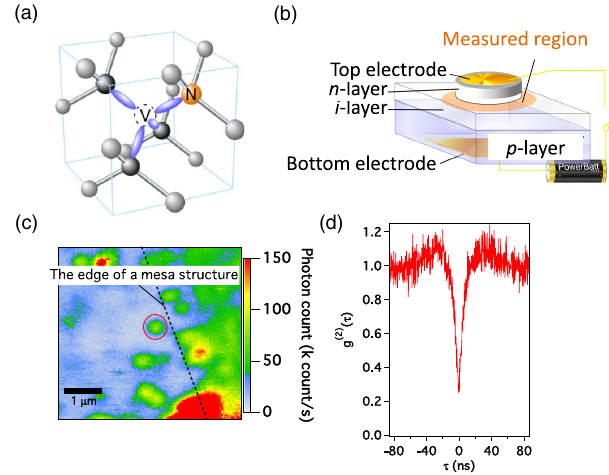
FIG. 1. (a) Structure of a NV center comprising a substitutional nitrogen atom and a neighboring vacancy in the diamond lattice. (b) Sketch of the p - i - n structure of the diamond diode. The thicknesses of the p -type, intrinsic, and n -type layers of the device are 0.5 mm, 10 μ m, and 500 nm, respectively. (c) Confocal microscopy PL raster scan image of the intrinsic layer. All measurements (except the distance-dependence measurement) wereconductedontheNVcentercircledinred.(d)Thecorrespond- ing antibunching statistics of the NV center in (c). g ð 2 Þ ð 0 Þ < 0 . 5 indicates photons originating from a single